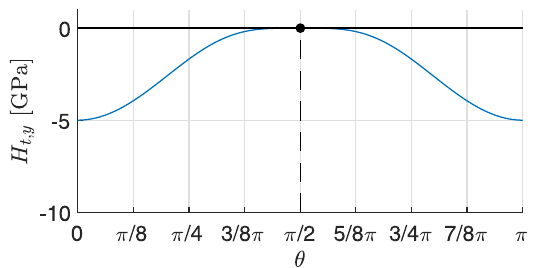
Figure 4. H ( θ ) for uniaxial tension in y